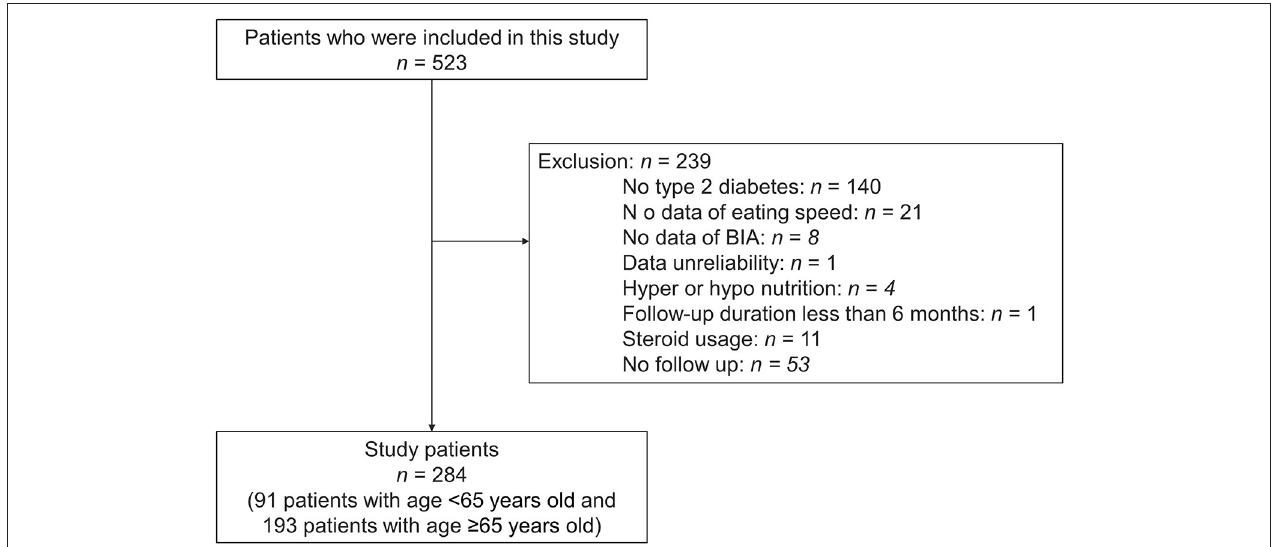
FIGURE 1 | Inclusion and exclusion flow. BIA, body impedance analyzer.